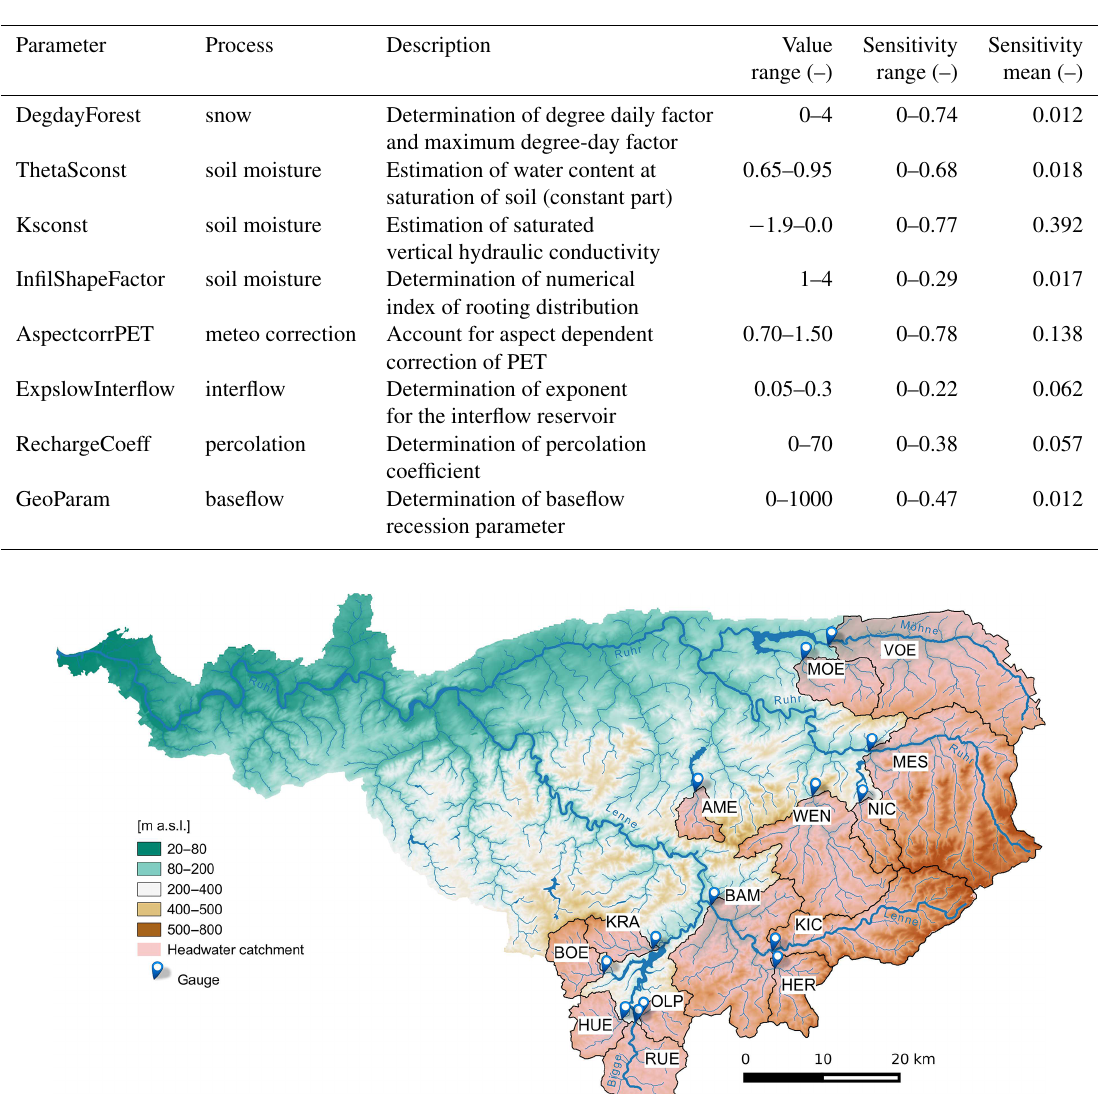
Table 2. Eight global mHM parameters (dimensionless): function, value range for FAST, range and arithmetic mean of sensitivity values (TEDPAS) across 14 Ruhr headwater catchments (1997–2006).